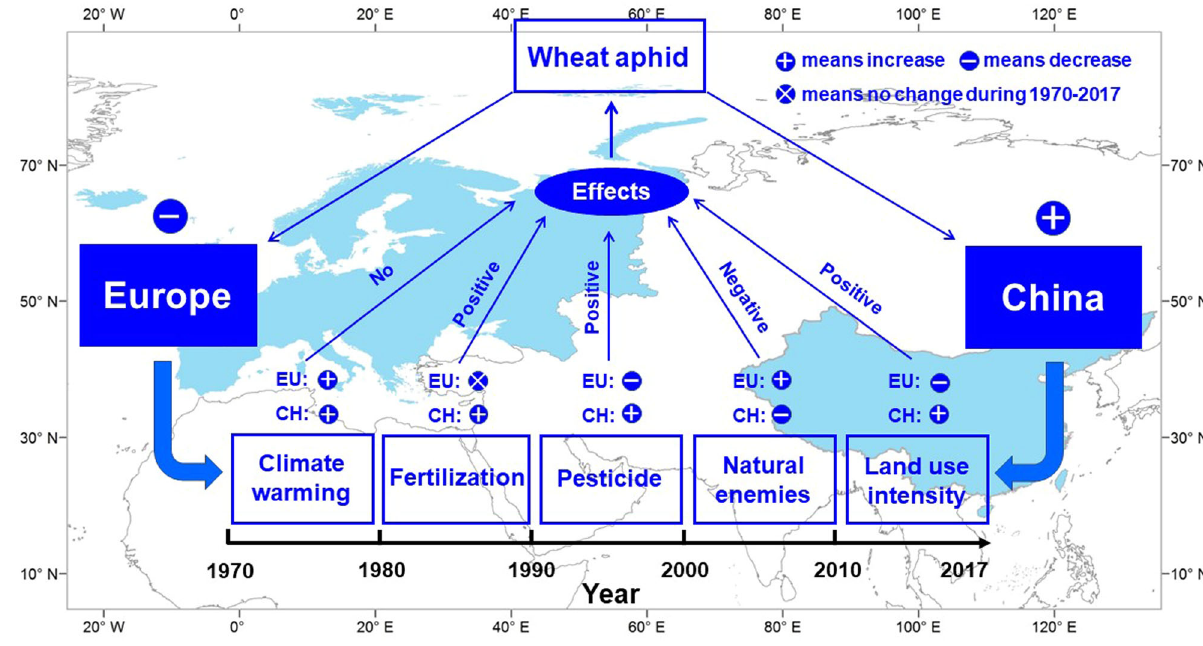
Fig. 6 Conceptual overview of the variation of wheat aphid and its associated factors between China and Europe during 1970 to 2017. This map was created by using the ArcGIS 10.3.1 software (ESRI, Redlands, CA, USA,